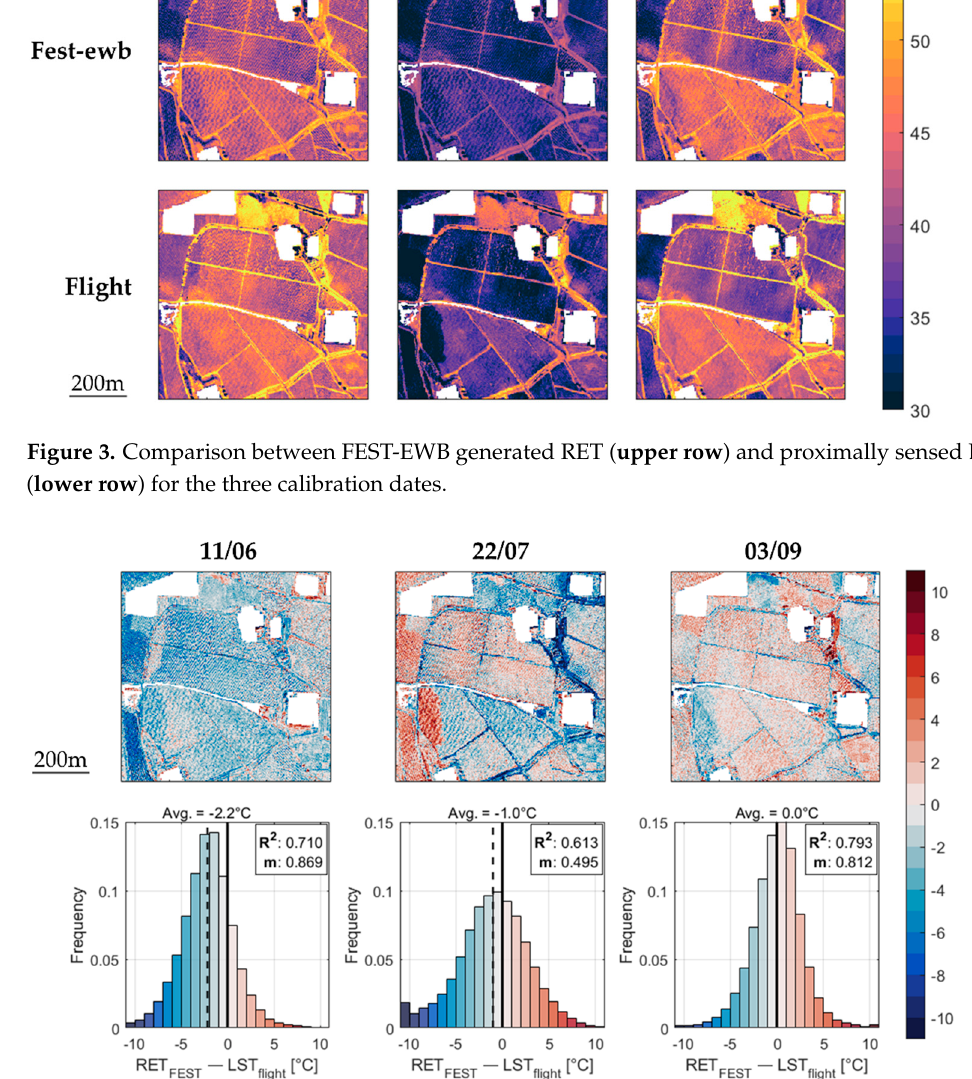
Table 3. Calibration statistics: Bias (B), linear interpolation slope (m) and determination coefficient (R 2 ) on a global level. Root-Mean-Square-Error (RMSE) global and sorted by Leaf Area Index (LAI). Date